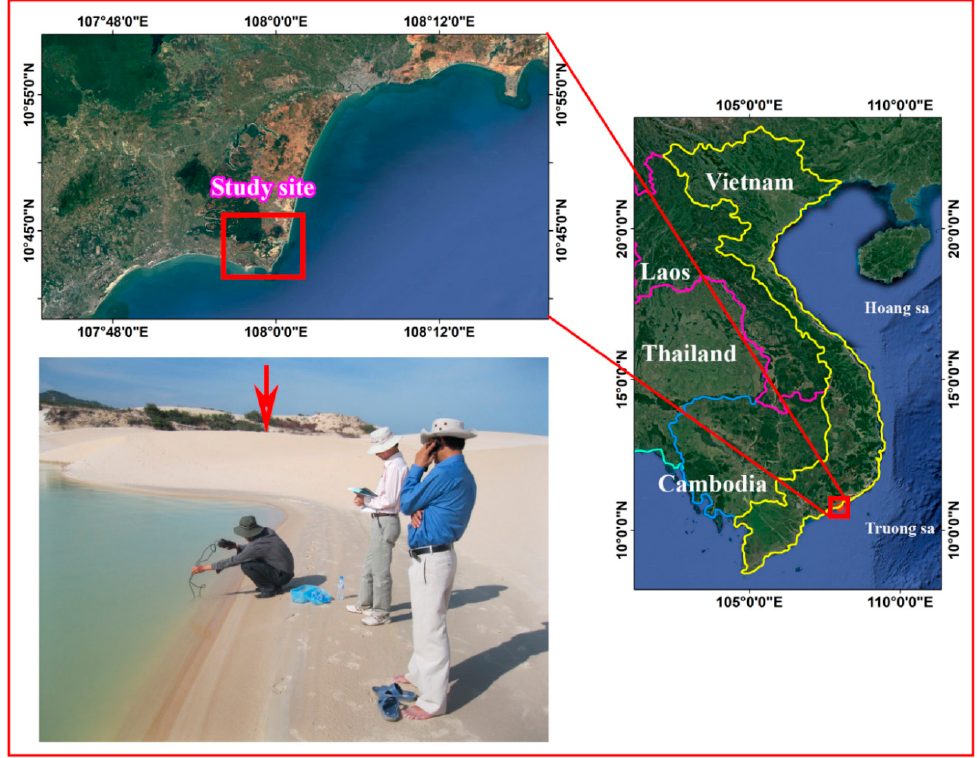
Figure 4. A view of the Southern Suoi Nhum titanium placer mine (Vietnam).